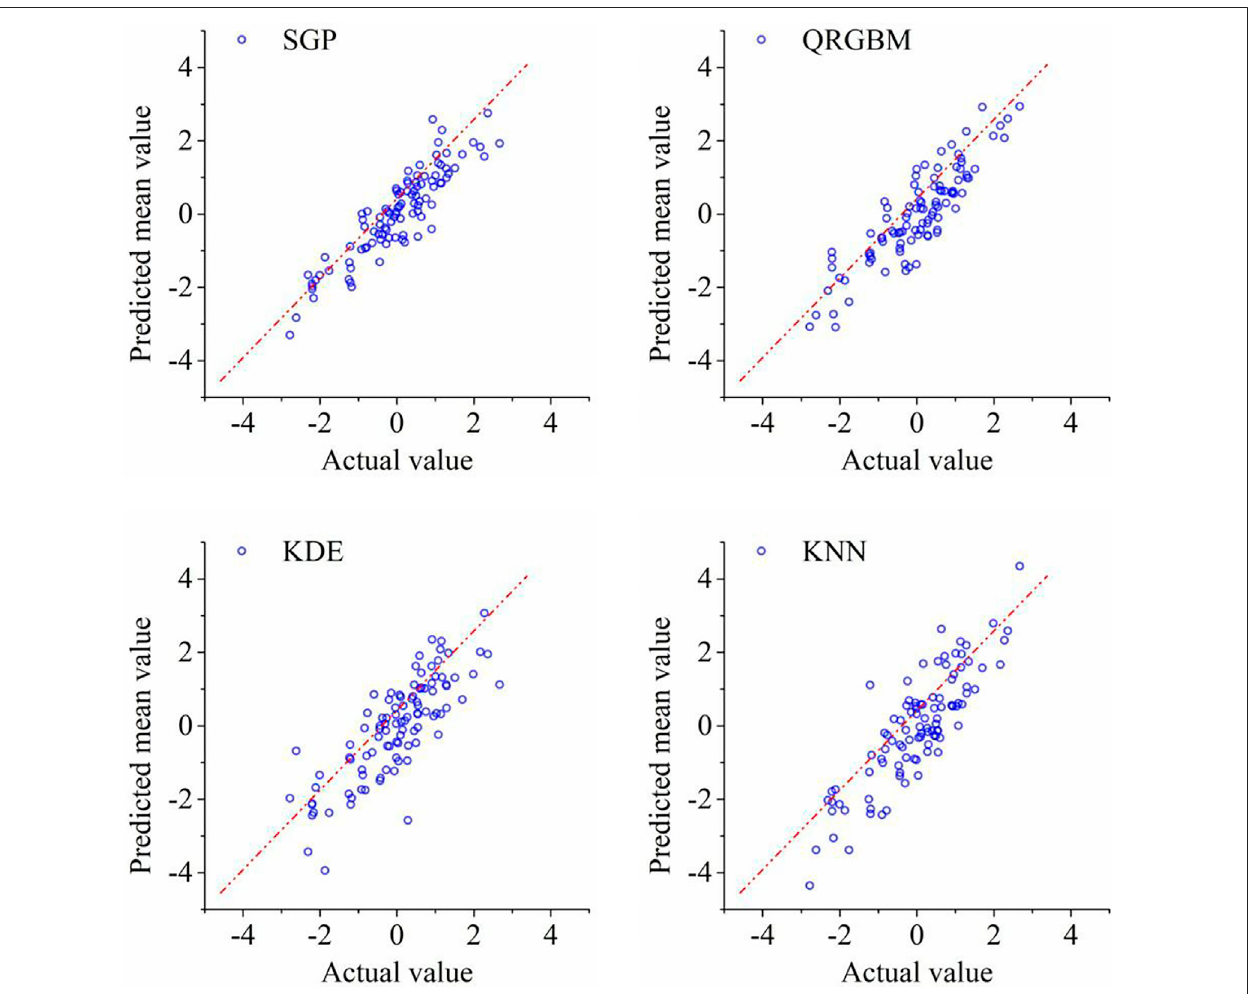
FIGURE 5 | Actual value versus predicted mean value for all algorithms tested.